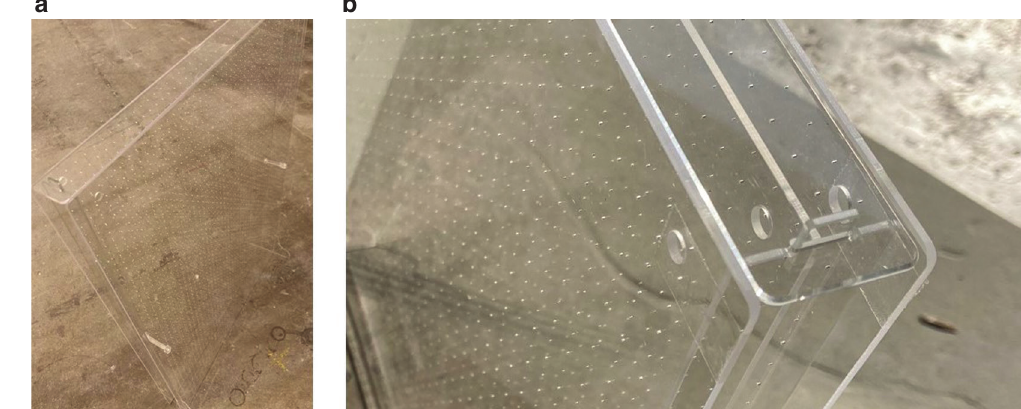
Photographs of Specimen (c). (a) The top and side areas were closed using acrylic sheets (unperforated). (b) The covering panels on the perimeters were not glued but fitted in with prongs and notches with other